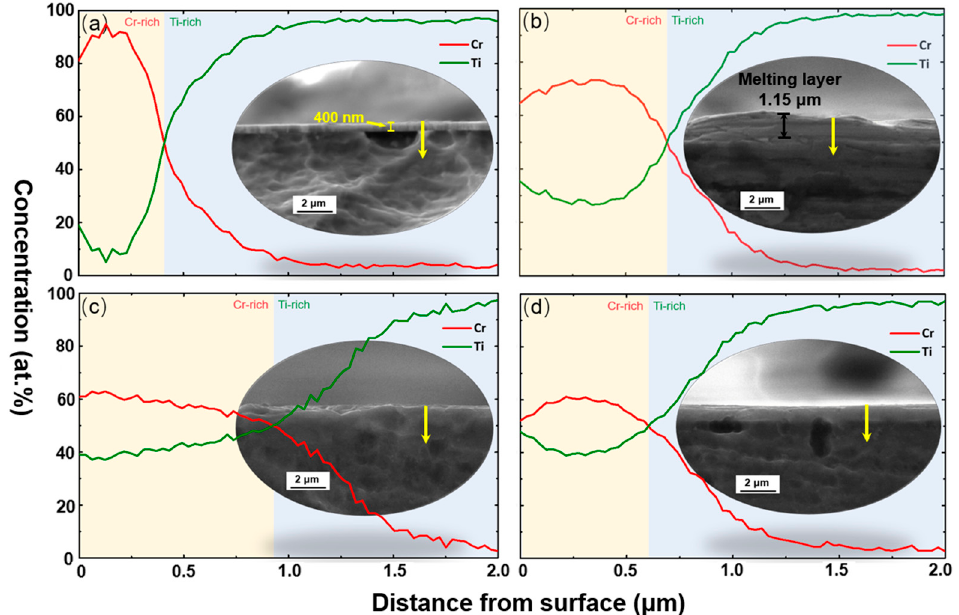
Figure 5. Cross-sectional EDS linear analysis of element distribution of Cr/Ti, according to the yellow arrow, for the ( a ) unirradiated sample, and ( b – d ) the irradiated samples with 1, 5, and 20 pulses of IPIB treatment, respectively.